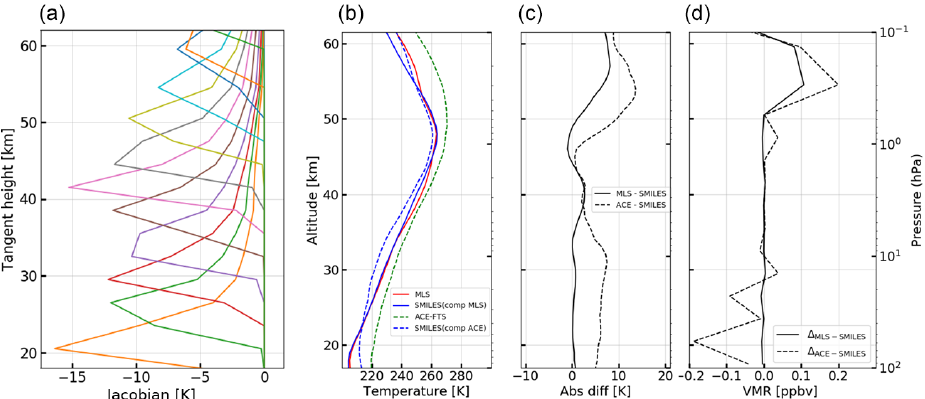
Figure 12. (a) The lines represent the Jacobian for the temperature calculated using the mean profile from the SMILES winter midlatitude region (20–40 ◦ S). The units of the Jacobian ( x axis) are Kelvin. (b) Temperature profile of each instruments. The solid blue and red lines indicate the mean SMILES and MLS temperature profiles within the coincidence criteria used for the HCl comparisons. The dashed blue and green lines indicate the SMILES and ACE-FTS temperature profiles for the same coincidence criteria. (c) The absolute difference of temperature profiles between SMILES and other instruments calculated using Eq. (3). (d) The difference in HCl profiles calculated using Eq.